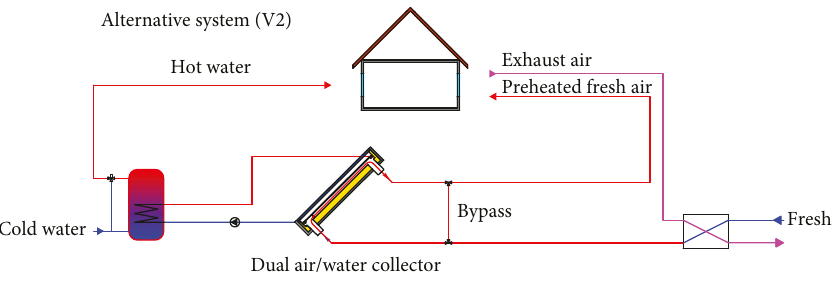
Figure 13: The con fi guration of the alternative system V2.